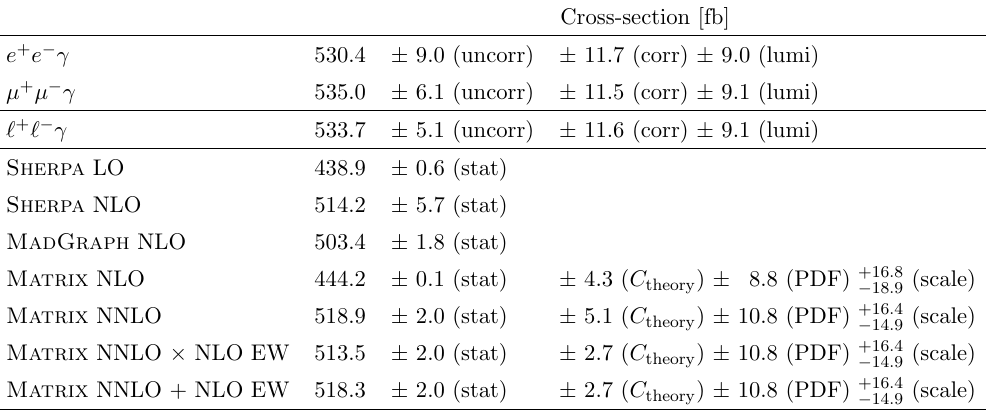
Table 6 . Measured cross-sections ((cid:12)rst three rows) for ‘ + ‘ (cid:0) (cid:13) production within the particle-level (cid:12)ducial phase-space region de(cid:12)ned in table 4, compared with (next (cid:12)ve rows) corresponding SM expectations obtained from the Sherpa event generator at LO and NLO, MadGraph5 aMC@NLO event generator at NLO, and from the Matrix generator at NLO and NNLO. For the measured cross-sections, the (cid:12)rst uncertainty is due to all sources which are uncorrelated between the e + e (cid:0) (cid:13) and (cid:22) + (cid:22) (cid:0) (cid:13) channels (including the statistical uncertainty), while the second is the remaining systematic uncertainty, excluding the uncertainty in the integrated luminosity, shown